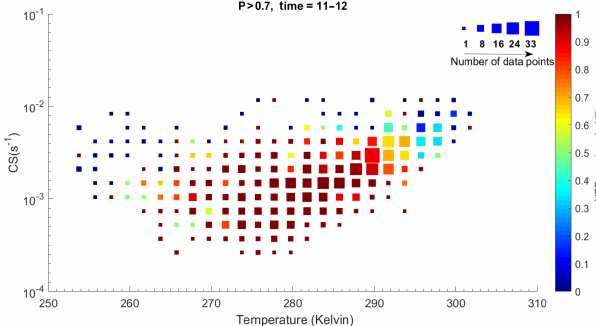
Figure 13. NPF probability distribution based on the CS and tem- perature conditions during clear-sky days (11:00–12:00). Marker size indicates number of days included in the probability calcula- tion within every